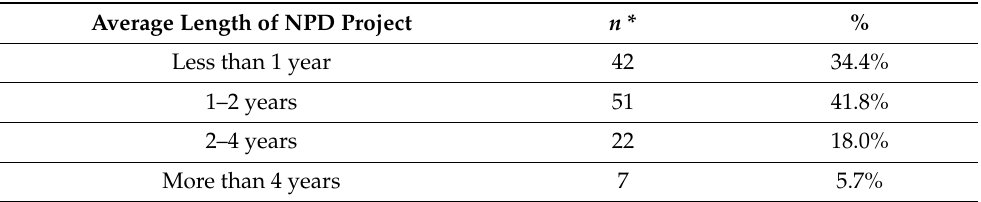
Table 6. Average length of New Product Development (NPD)